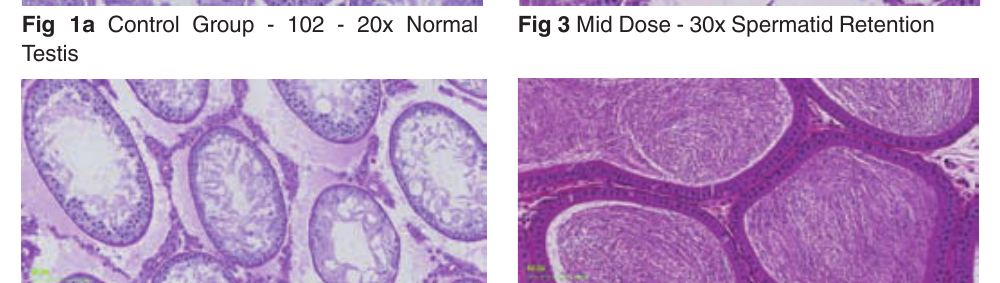
Fig 4a Control - 20x caput